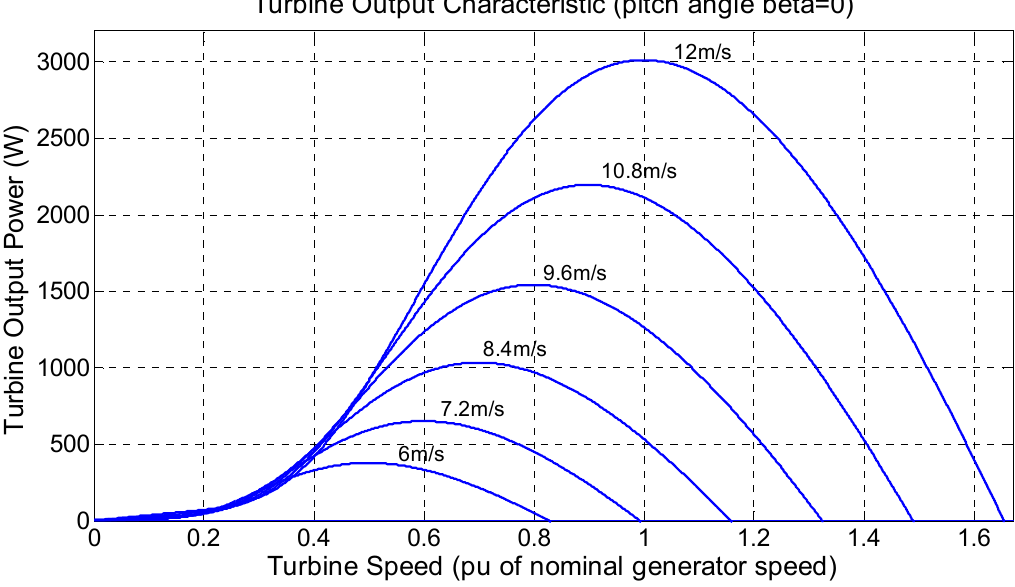
Figure 21. Turbine power output versus turbine speed for a given wind speed.